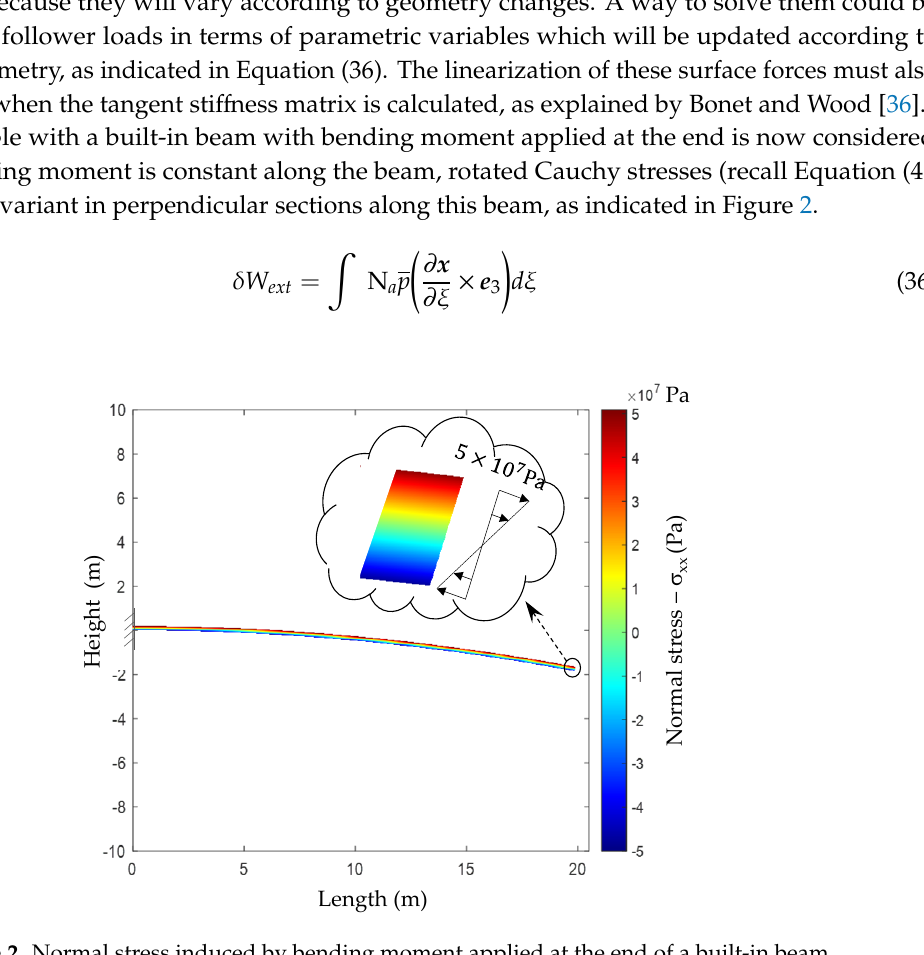
Figure 2. Normal stress induced by bending moment applied at the end of a built-in beam.